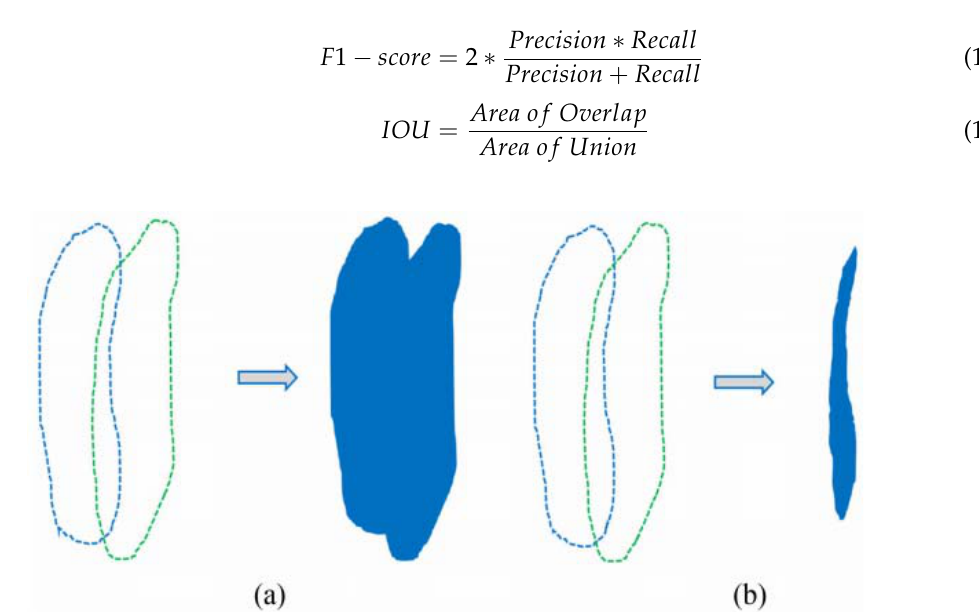
Figure 15. Illustration of the ( a ) area of union and that of the ( b ) overlap [48]. Parameters including TP (true positive), FP (false positive), and FN (false negative)